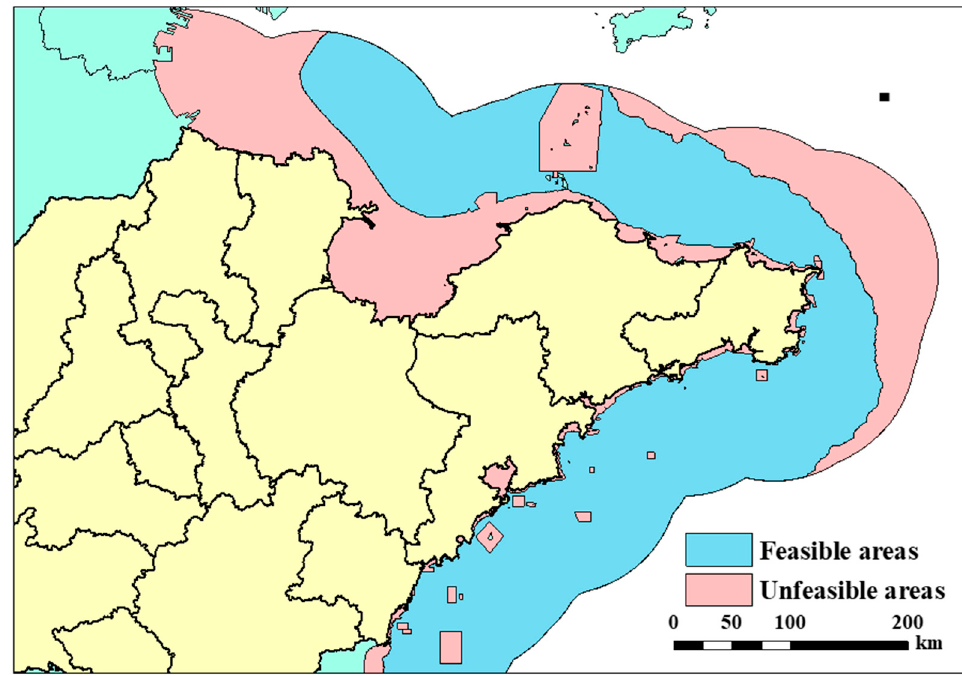
Figure 5. Unfeasible areas and feasible areas.